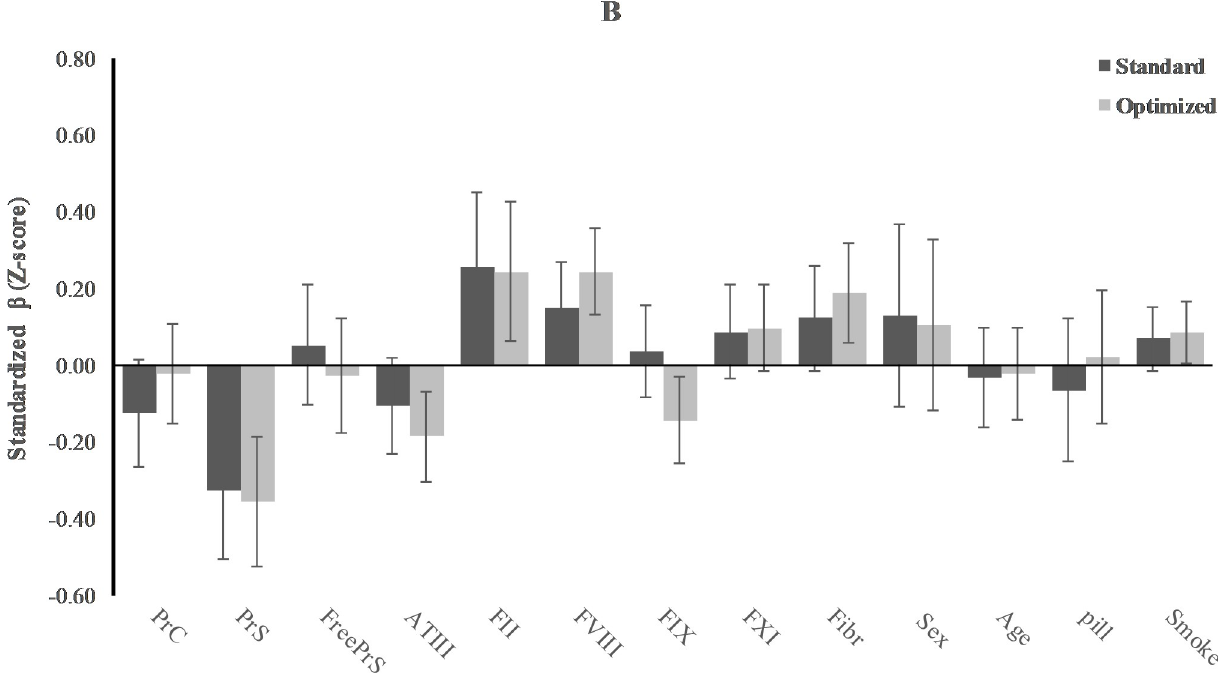
Fig 5. Effect of CTI on relative contribution of coagulation factors to thrombin generation measured with TGA. Mean change in thrombin generation with 1 standard deviation (SD) increase in coagulation determinants, while other determinants remain the same. Results for standard versus optimized